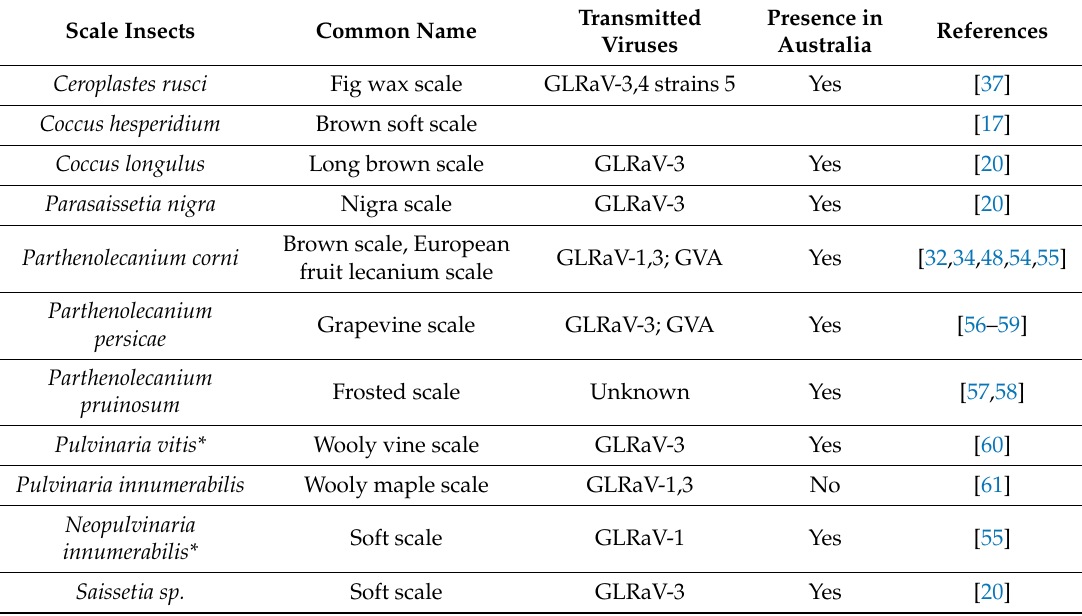
Table 3. Common scale insect vectors of grapevine